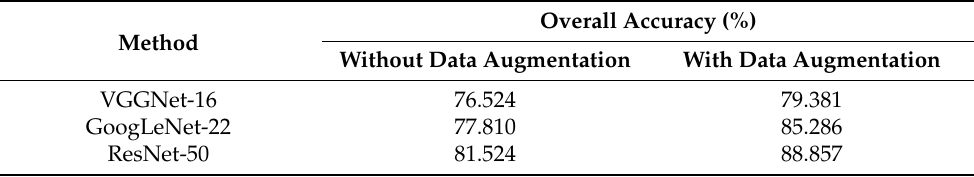
Figure 9. CM of MGCNN-C4 derived with the RSI-CB dataset. Table 5. Overall accuracy (OA) of base networks with data